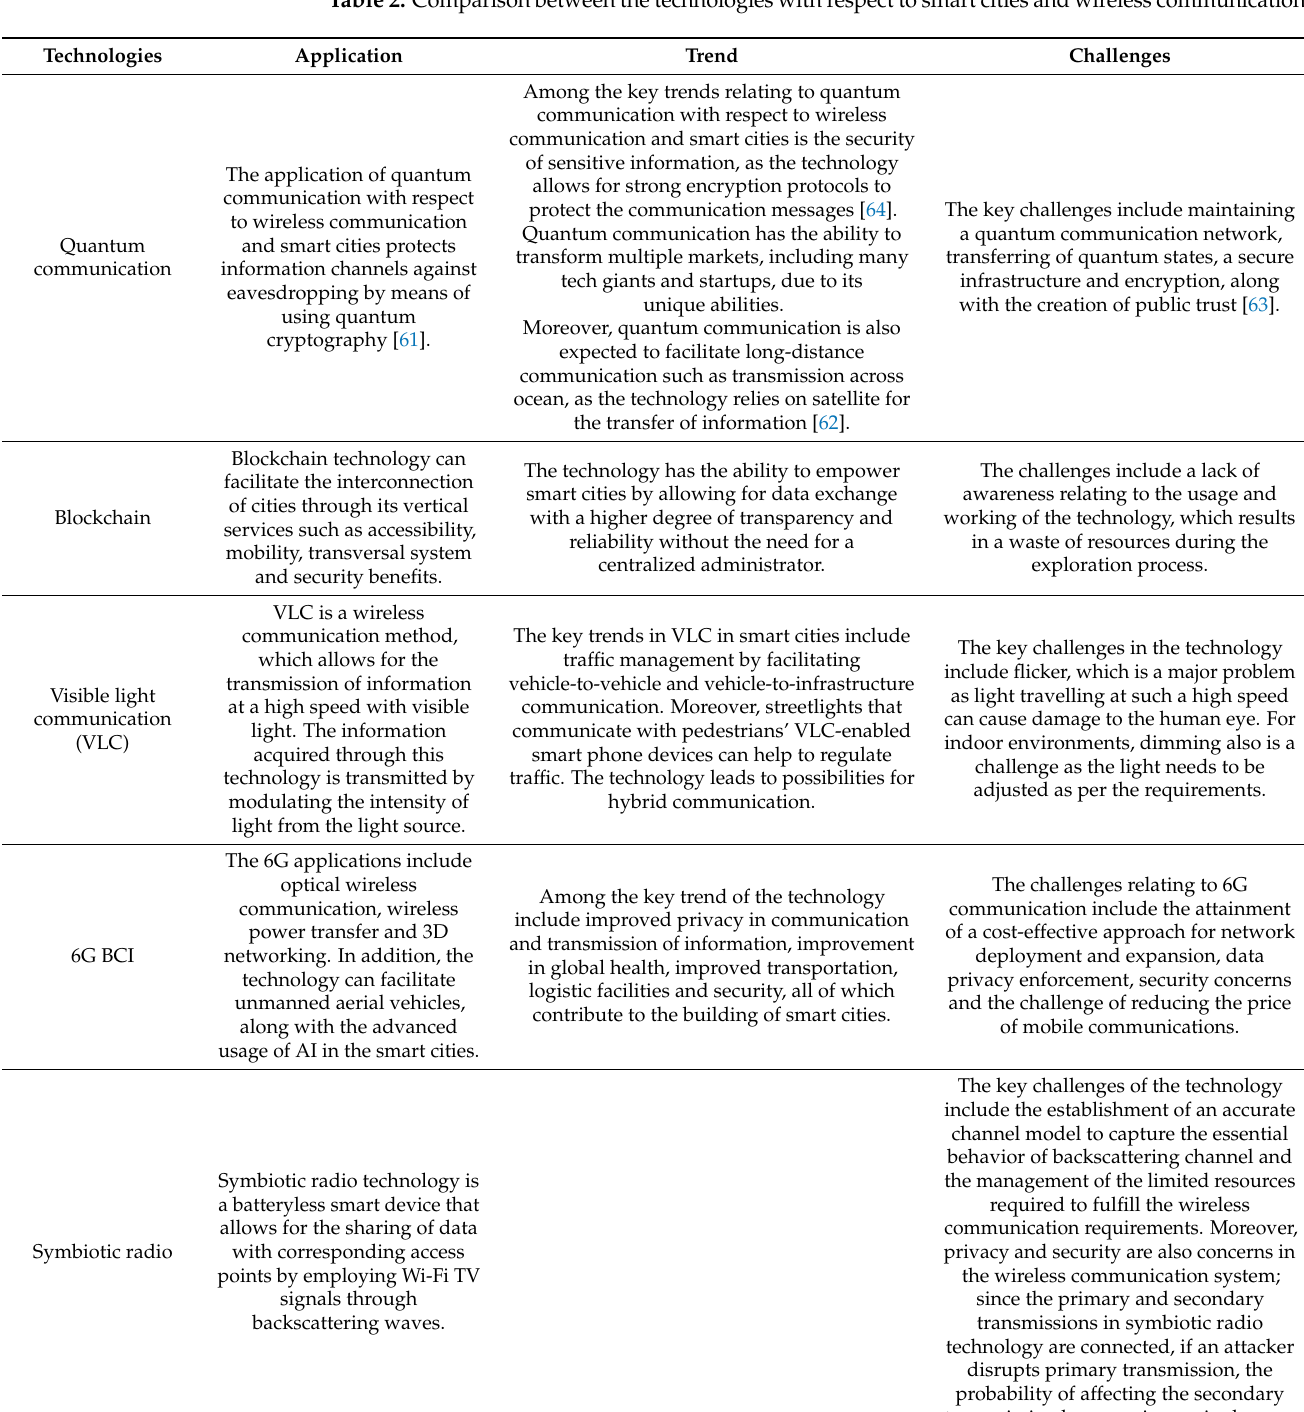
Table 2. Comparison between the technologies with respect to smart cities and wireless